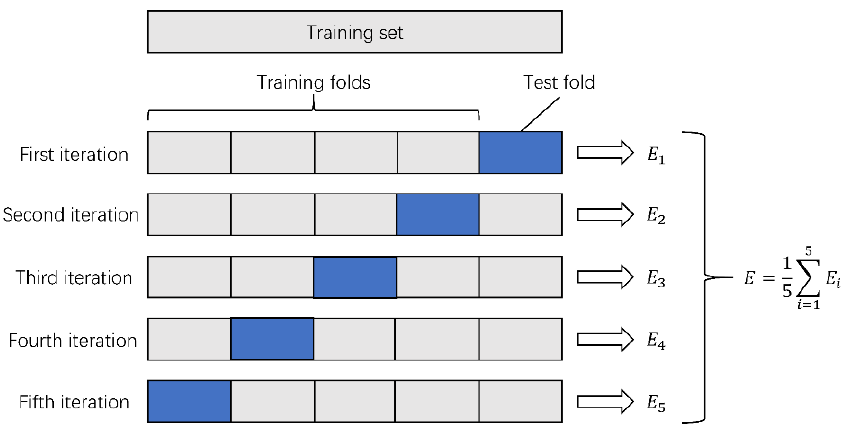
Figure 2. The process of fivefold cross-validation.